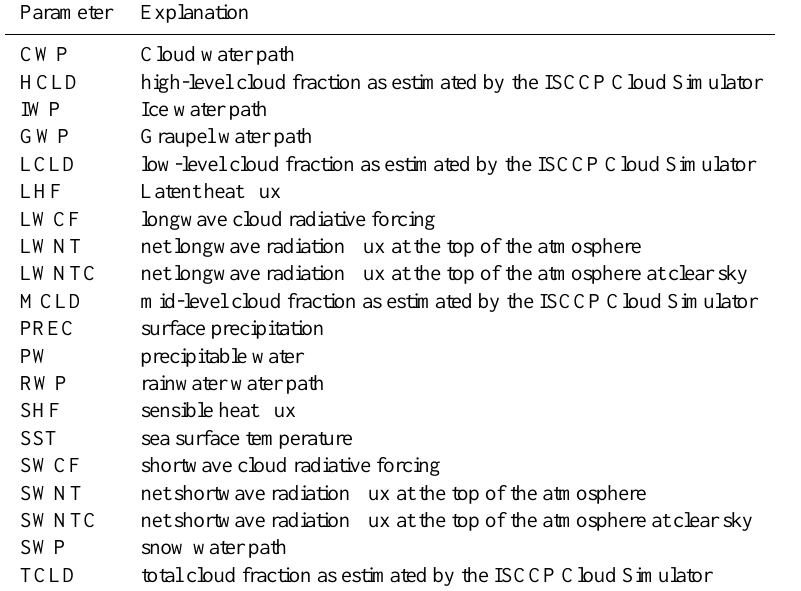
Table 3. Abbreviations.